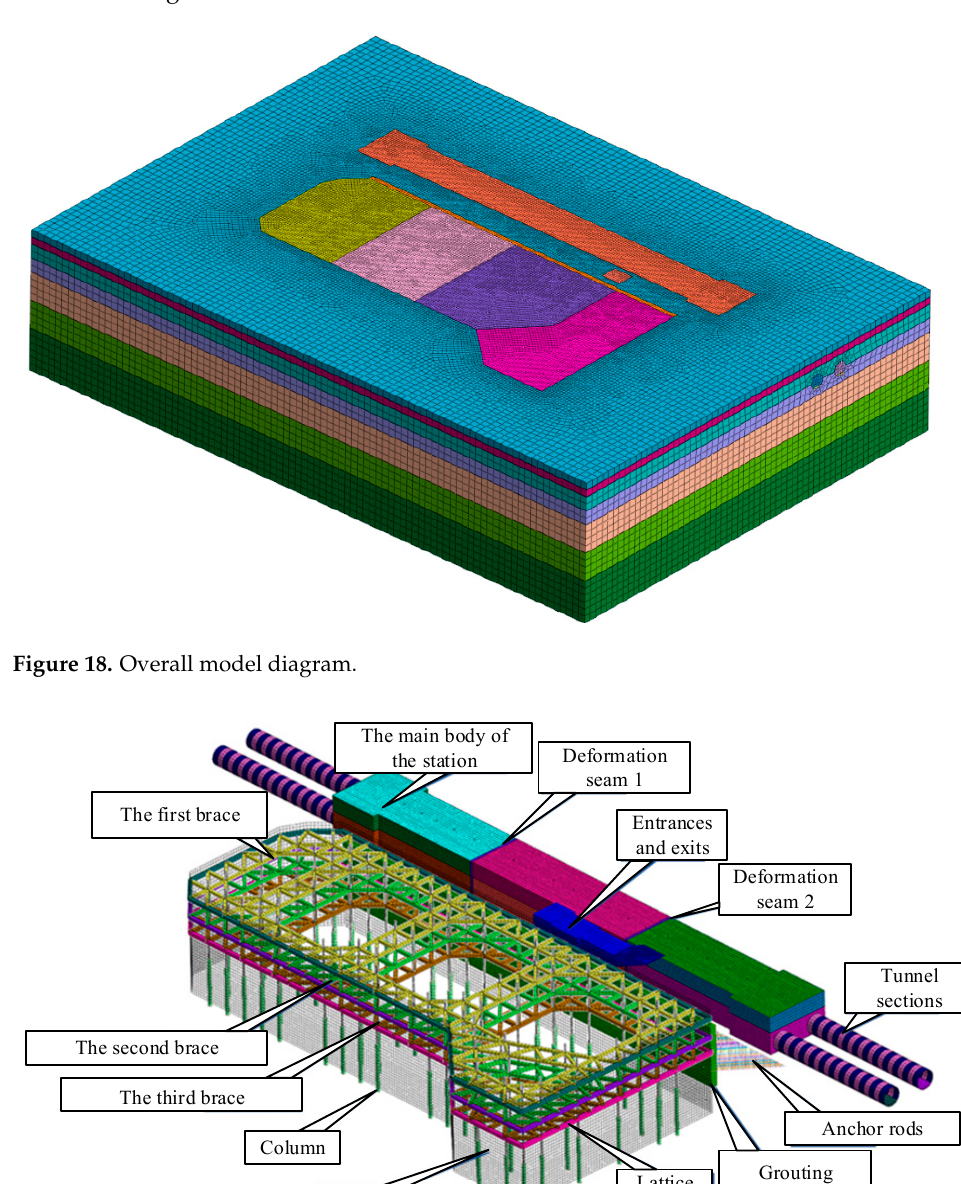
Figure 18. Overall model diagram.